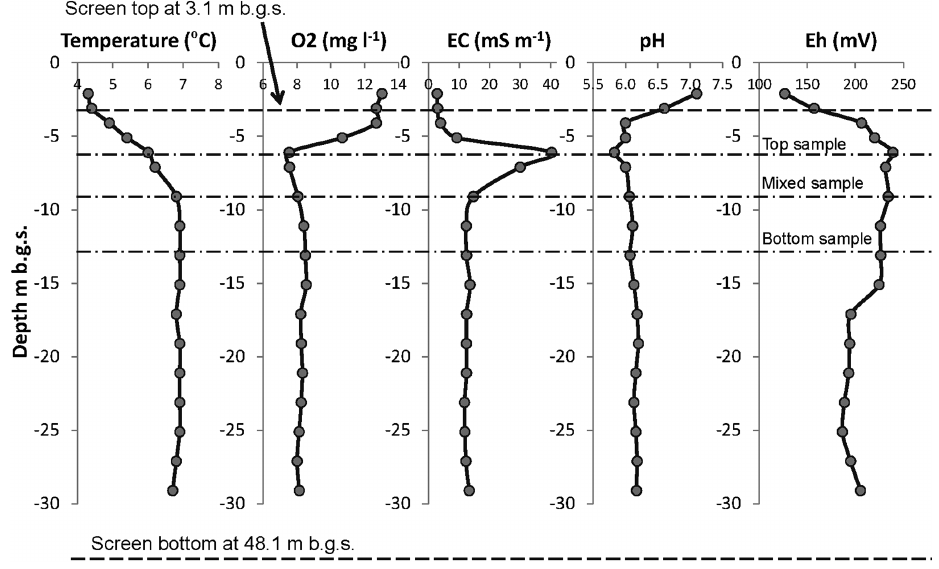
Figure 4. Depth profile of parameters: temperature, dissolved oxygen (O 2 ) , electrical conductivity (EC), pH and redox potential (Eh), in the well screen section of Obs6 (50m from the highway) during spring 2012. m b.g.s = metres below ground surface.